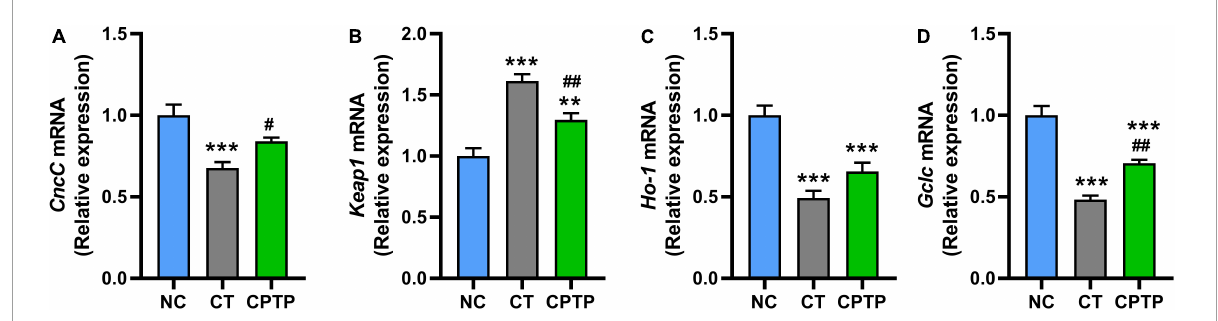
FIGURE5 Chinese pond turtle peptide (CPTP) upregulated the Nfr2-mediated signaling pathway in female flies. The gene expression level of (A) CncC ; (B) Keap1 ; (C) Ho-1 ; and (D) Gclc . n = 180–210 flies per group. The data are presented as mean ± SEM. Statistical test: two-tailed unpaired t -test (* P < 0.05, ** P < 0.01, and *** P < 0.001 vs. NC group; # P < 0.05 and ## P < 0.01 vs. CT group).